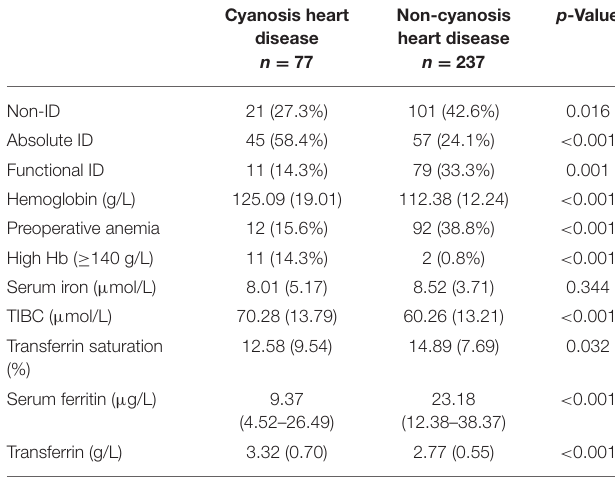
FIGURE 4 | Distribution of ID patterns in patients with cyanotic heart disease. AID, absolute iron deficiency; FID, functional iron deficiency; non-ID, non-iron deficiency. TABLE 4 | Preoperative status of iron deficiency in cyanosis heart disease